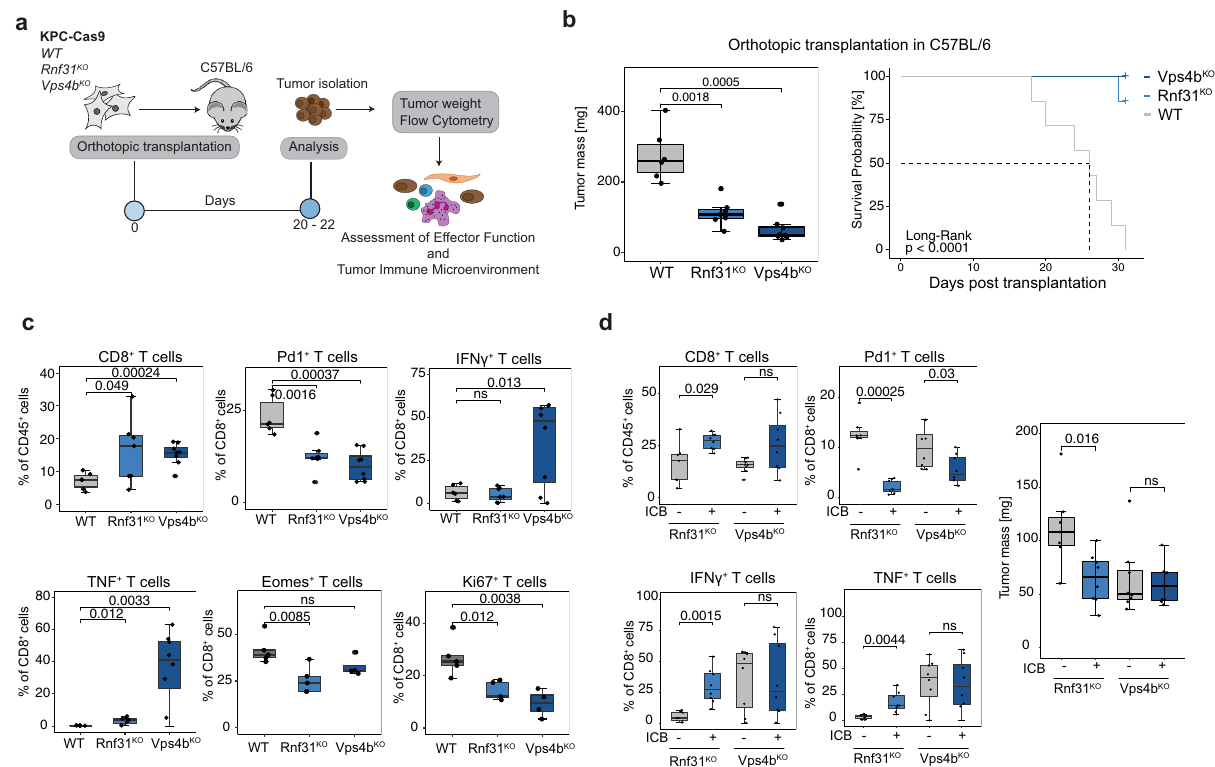
Fig. 6 Rnf31 KO and Vps4b KO enhances CD8 + T cell function in vivo. a Schematic of in vivo experimental set up. b Tumor weight (left panel; n for WT = 6; Rnf31 KO = 7; Vps4b KO = 8) and survival (right panel; n = 7 per group) after orthotopic transplantation into C57BL/6 mice. Log-Rank test was performed to assess statistical signi fi cance in Kaplan – Meier plot. c Flow cytometry analysis of effector function of CD8 + T cells within tumors; n in WT = 6; Rnf31 KO = 7; Vps4b KO = 8; panels Eomes + and Ki67 + n = 5 per group for all genotypes). d Assessment CD8 + T cell effector function and tumor weight (right panel) in Rnf31 KO or Vps4b KO tumors with or without immune checkpoint inhibition (ICB); n = 8 per group). Signi fi cance in ( b , left panel), ( c , d ) was determined with unpaired two-tailed t tests; ns, non-signi fi cant, p > 0.05. The middle line in the boxplots shows the median, the lower and upper hinges represent the fi rst and third quartiles, and whiskers represent ±1.5× the interquartile range. Source data are provided as a Source Data fi